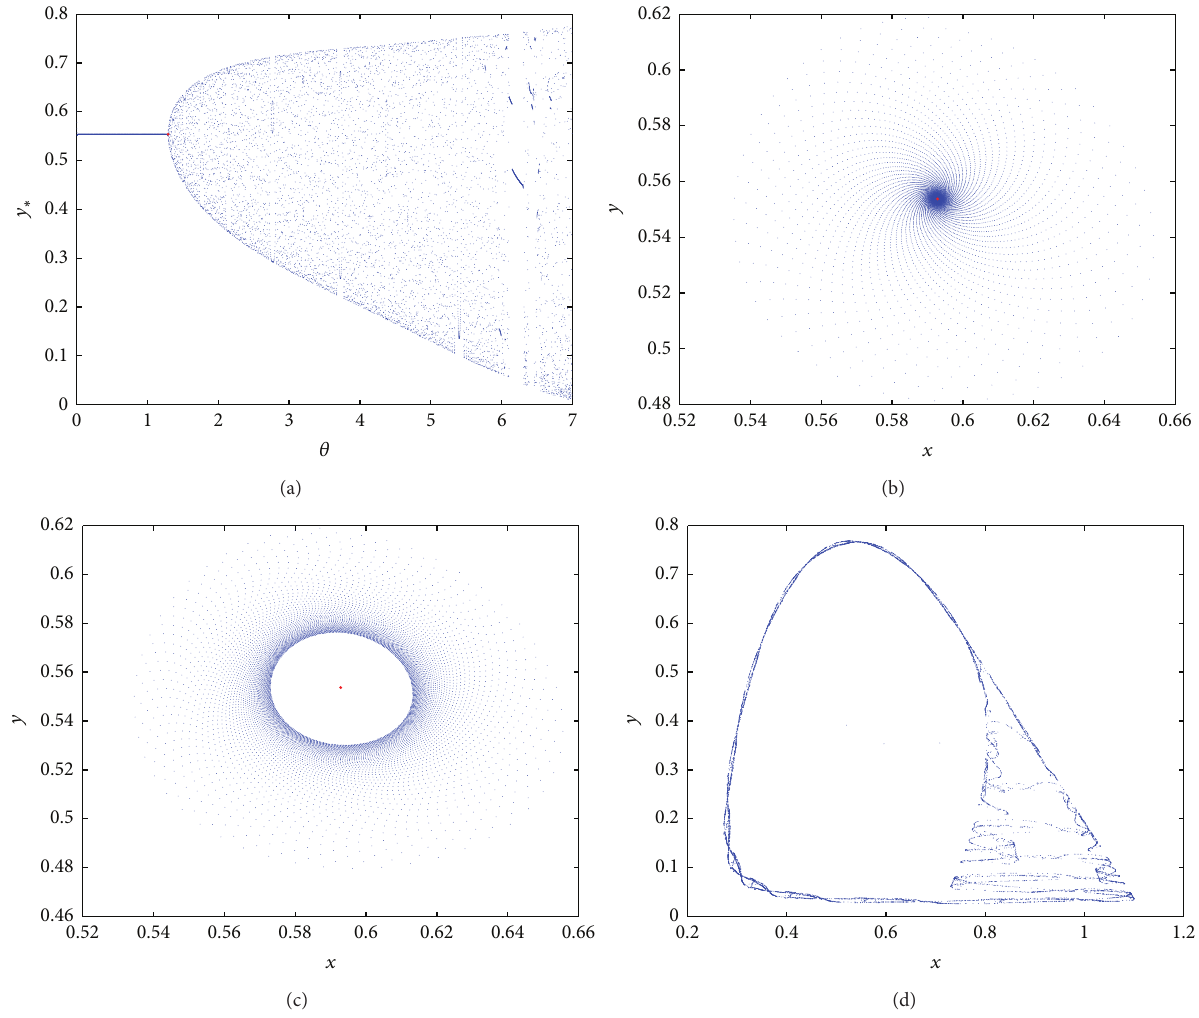
Figure 1: (a) The bifurcation diagram of system (4) with 𝜃 varying in (0.2, 2) . The system undergoes a Neimark-Sacker bifurcation when (0.5928, 0.5537) exists when 𝜃 = 1.2 which occurs before the bifurcation. 𝜃 ≈ 1.290556794 (denoted by red point). (b) A stable fixed point 𝐸 ∗ (c) An invariant closed curve around the fixed point 𝐸 ∗ created after the bifurcation which exists for 𝜃 = 1.3 . (d) A chaotic attractor occurs when 𝜃 = 6.6